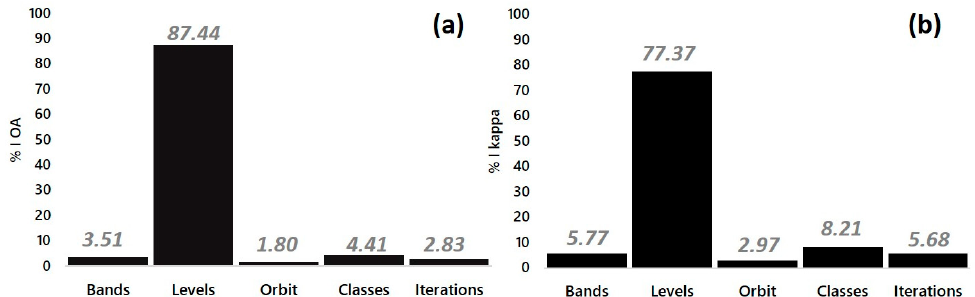
Figure 8. Bar plots of the independent contribution of the explained variables as a percentage of total explained variance. ( a ) Results using OA as the numerical variable; ( b ) Results using kappa as the numerical variable.